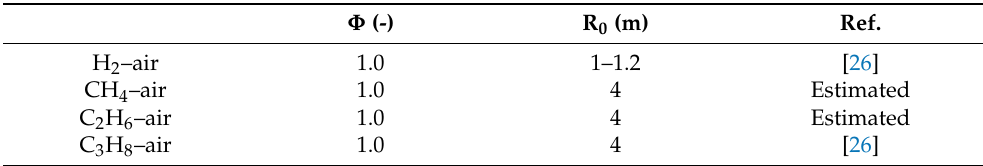
Figure 4. Leading point factor Ξ LP (effect of preferential diffusion) [23] for: ( a ) CH 4 –air, ( b ) C 2 H 6 –air, and ( c ) C 3 H 8 –air. Table 1. R 0 —characteristic dimension-radius at which transition to the self-similar turbulent regime takes place.